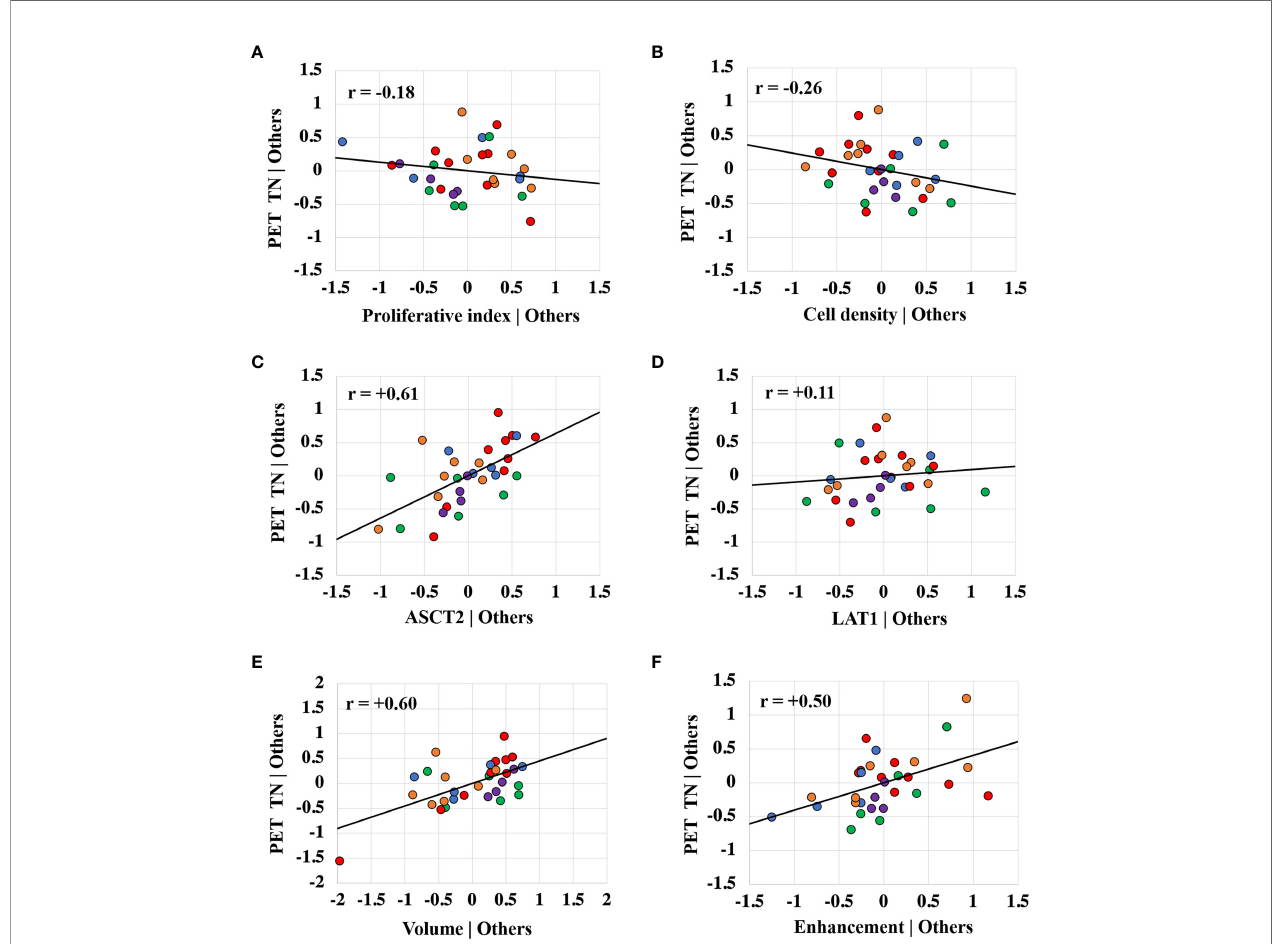
FIGURE 6 | Partial regression plots showing the linear relationship between the PET tumor-to-normal brain uptake ratio (TN 15-35 ) and the proliferative index (A) , cell density (B) , ASCT2 level (C) , LAT1 level (D) , tumor volume (E) , and gadolinium enhancement status (F) . Each data point represents measurements summarized for a single tumor and the color indicates the tumor line. The r value is the Pearson correlation coef fi cient. The linear regression line has intercept of zero and a slope equal to the multivariate linear regression coef fi cient tabulated in Figure 4 . The vertical axis in these plots represents the calculated residuals from a linear regression model with the PET uptake as a function of all other independent variables except the independent variable of interest. The horizontal axis represents the calculated residuals from a linear regression model with the independent variable of interest as a function of all the other independent